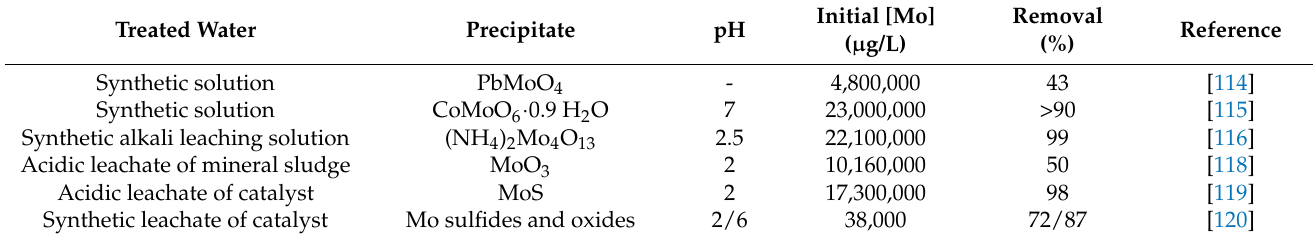
Table 10. Compilation of the main results of the precipitation conditions tested for molybdenum removal from aqueous